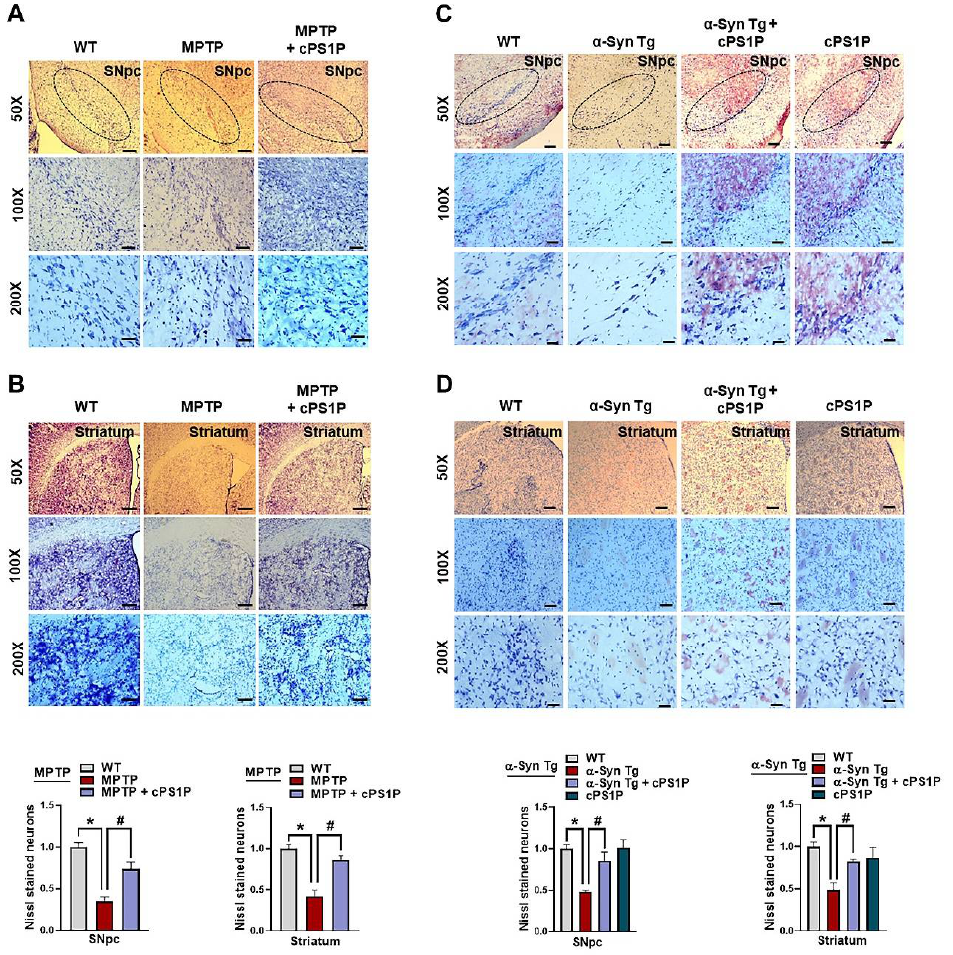
Figure 8. Effects of cPS1P against neuronal cell death in the SNpc and striatum of MPTP and NSE-h α Syn PD mouse models ( A , B ) Nissl staining of survival neurons in the substantia nigra pars compacta (SNpc) and striatum of the MPTP PD mouse model (n = 3 mice/group). ( C , D ) Nissl staining of survival neurons in the SNpc and striatum of the NSE-h α Syn PD mouse model (n = 3 mice/group). The values indicate the mean ± SEM. The significant differences have been given in the graphs. * Significant difference between the control and model group; # Significant difference between the model and cPS1P co-treated mouse. p < 0.05 was considered significant difference between the groups, as measured with one-way ANOVA followed by Tukey’s multiple comparison